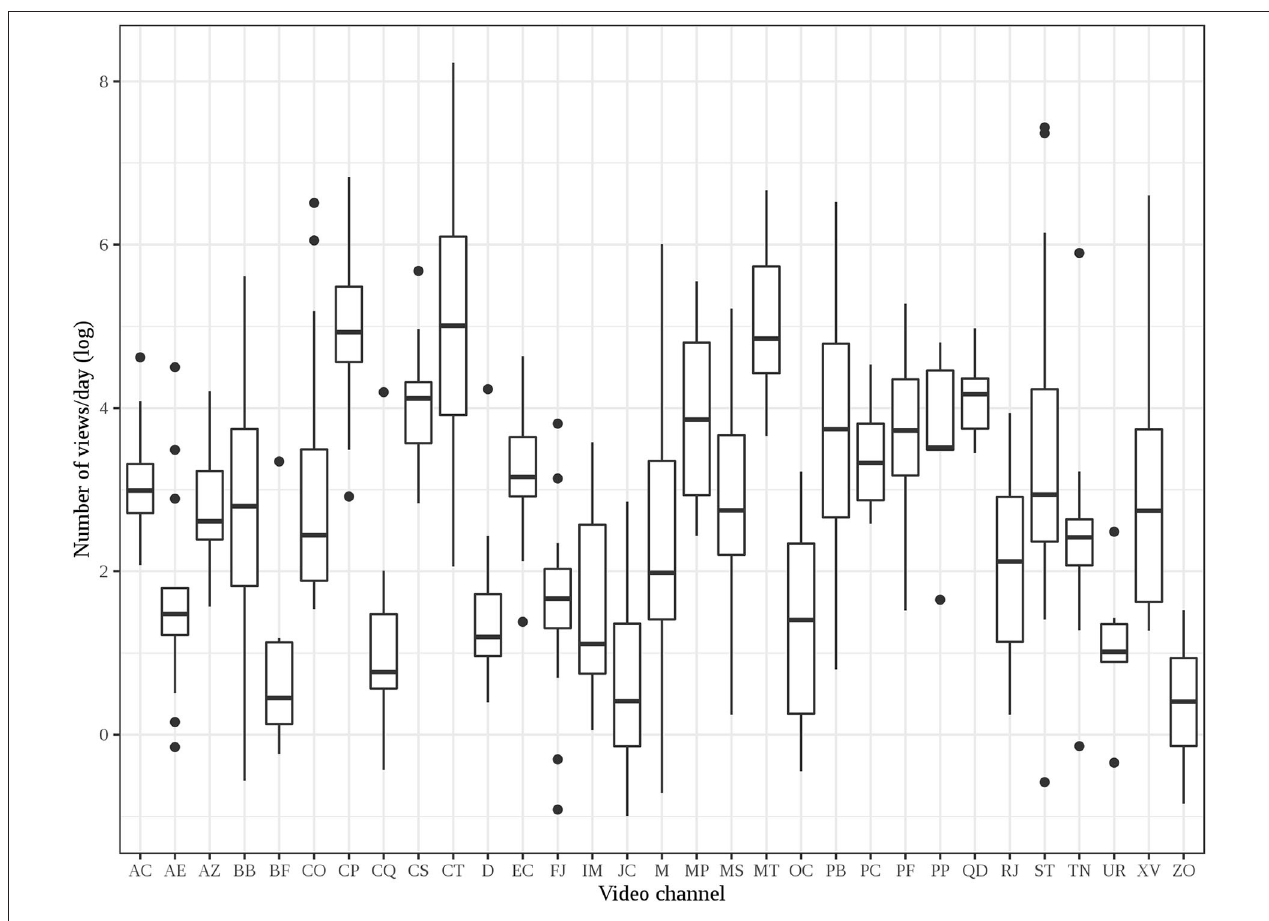
FIGURE 9 | Number of views per day (log) x channel (dots refer to outliers).